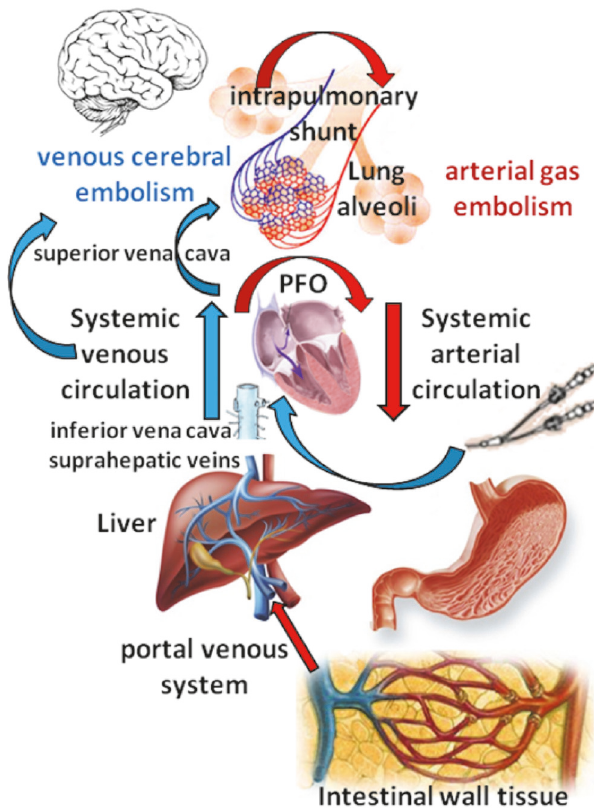
Figure 6: Routes of dissemination of